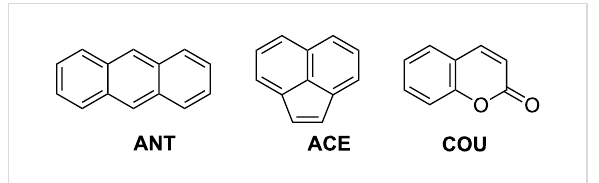
Figure 1: Chemical structures of selected aromatic guests: anthracene, ANT ; acenaphthylene, ACE ; and coumarin, COU .